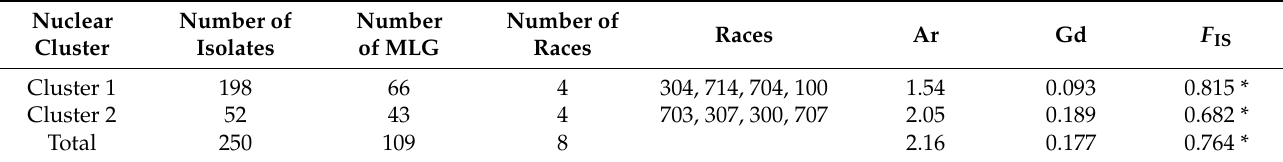
Table 5. Details and summary statistics for the genetic clusters defined by the program structure based on 13 nuclear loci. Cluster name, number of samples assigned to each cluster, number of unique genotypes, number of different races found in each cluster, names of races, mean allelic richness (Ar), gene diversity (Gd), and F IS value (* p < 0.01).